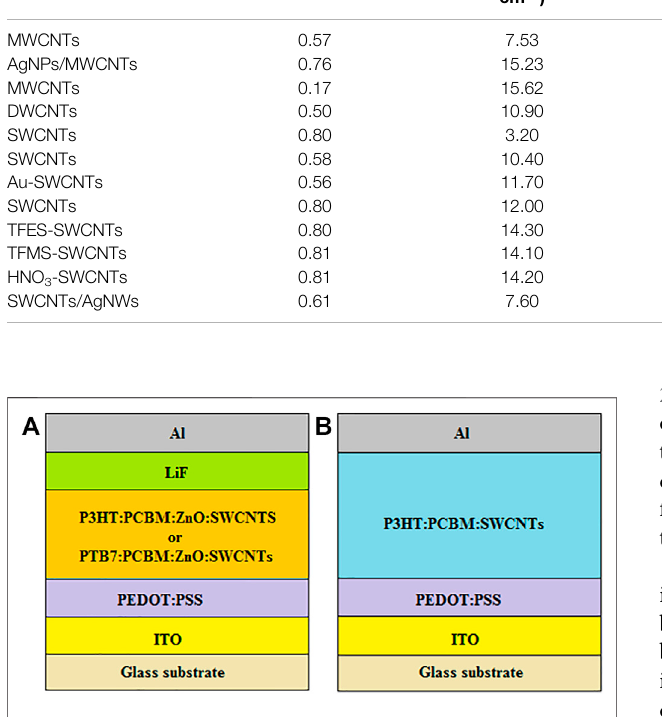
FIGURE 5 | Schematic diagram of conventional BHJ-OSCs with (A) ZnO:SWCNTs and (B) SWCNTs in the active